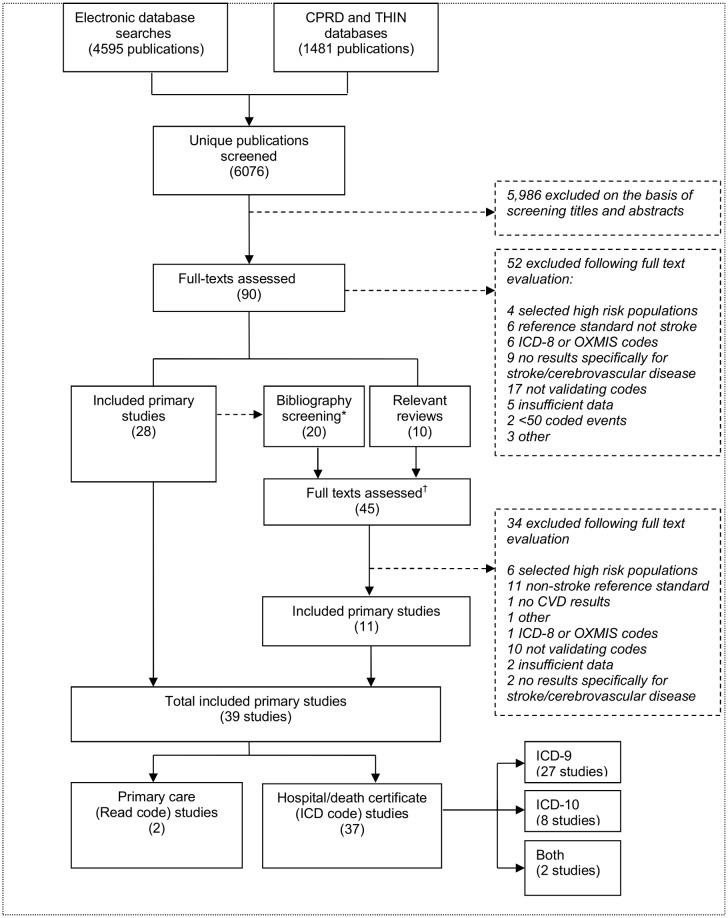
Selection of studies.
*Additional studies identified from bibliography screening.
†Additional studies identified from review articles and bibliography screening.